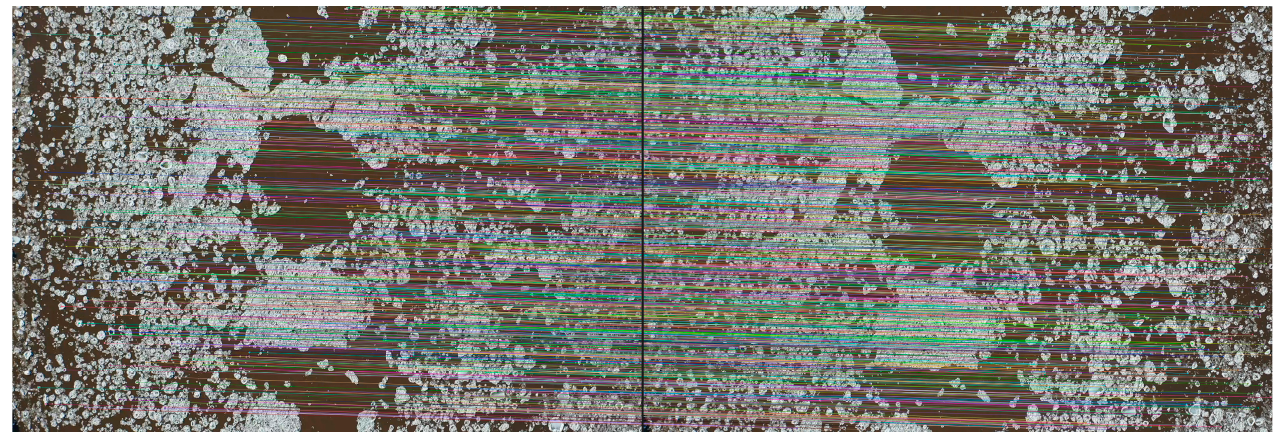
Figure 2. Fitting curve between the unit pixel length and actual length in remote sensing images at the different heights.